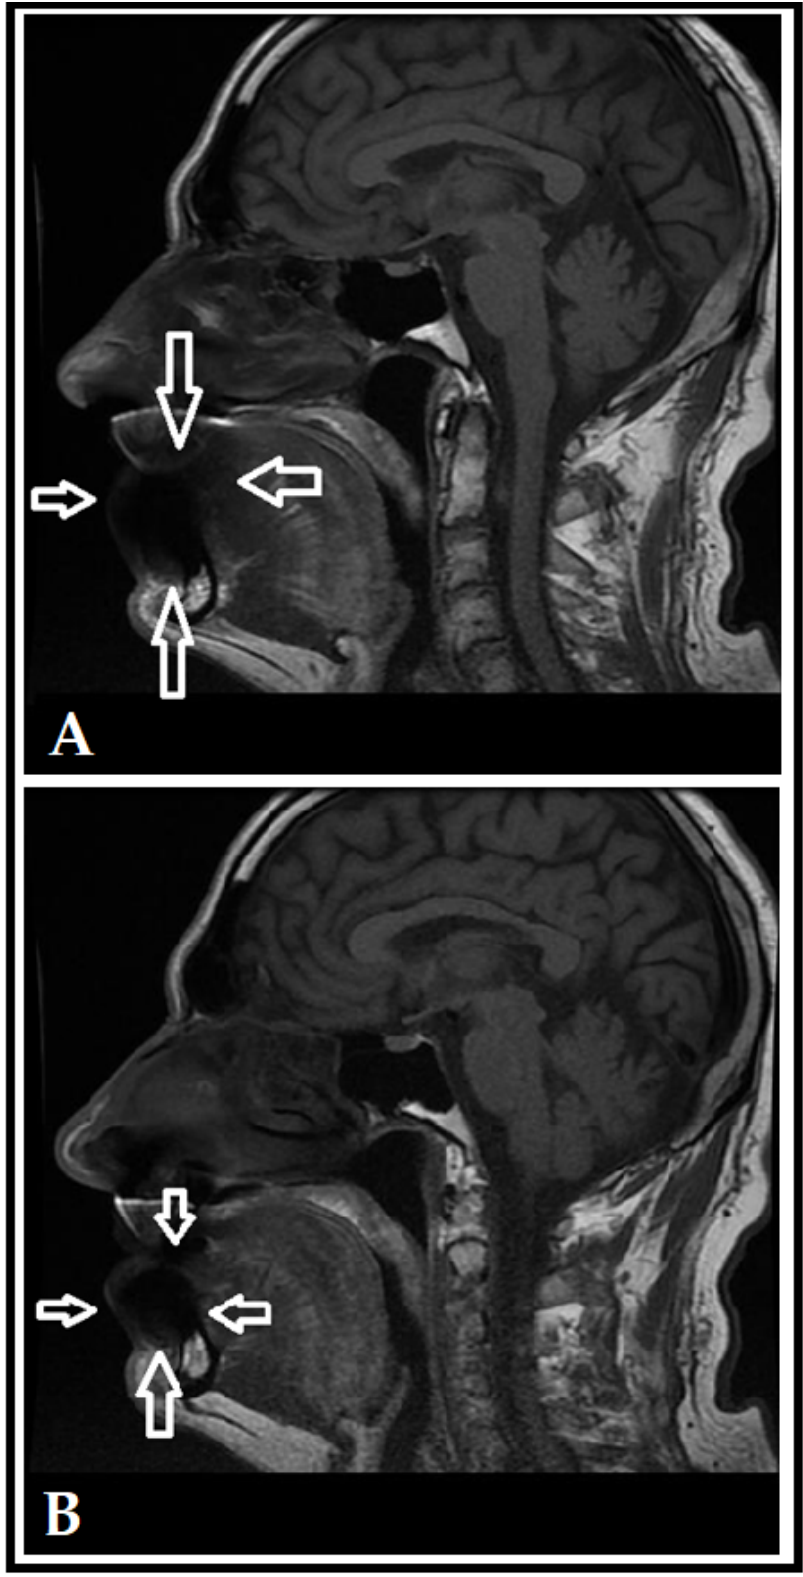
Figure 1. Unadjusted ( A ) and adjusted ( B ) MRI scans for Patient 1 (T1 sag). The shadow in the area of the lips (denoted by white arrows) indicates the imaging artefact caused by Cu accumulation in the lips, which is less pronounced after using adjusted directions and measurements.